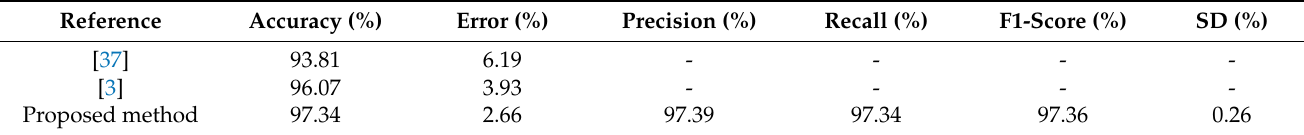
Table 5. Performance comparison of signed-letter recognition (letters A–Z).